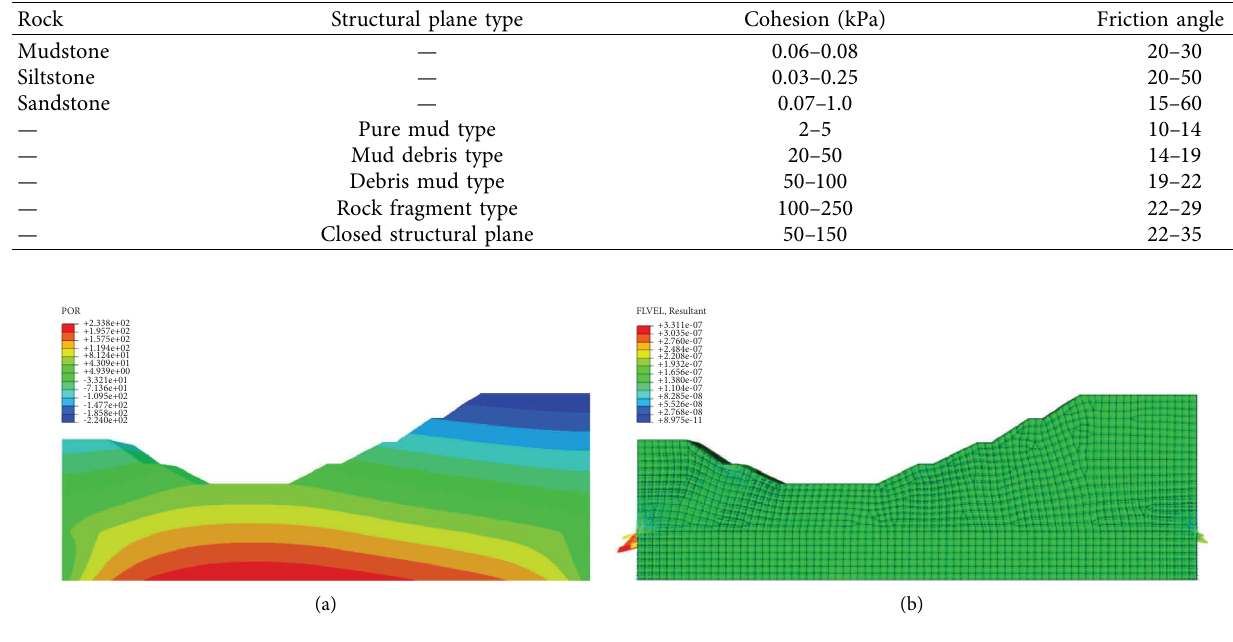
Figure 5: Seepage analysis of steady channel slope. (a) Pore water pressure nephogram; (b) fow feld distribution.